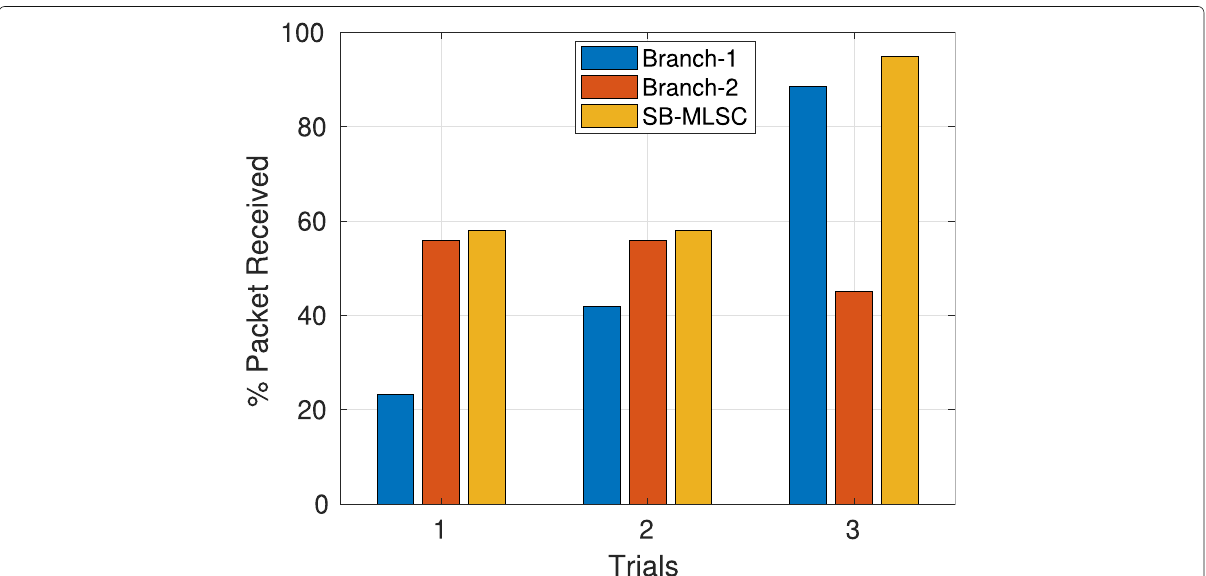
Fig. 22 Scrambled aluminum foils are placed inside RF cage resulting in multi-path reflections. In this case, SB-MLSC provides diversity gain, i.e., receives more packet than both branch 1 and branch